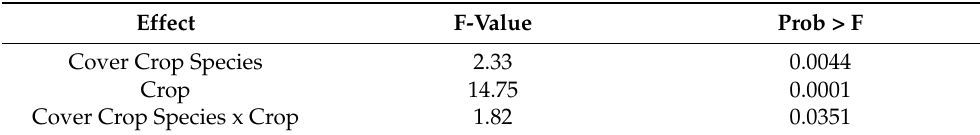
Table 5. ANOVA results for the breakeven price of hay.